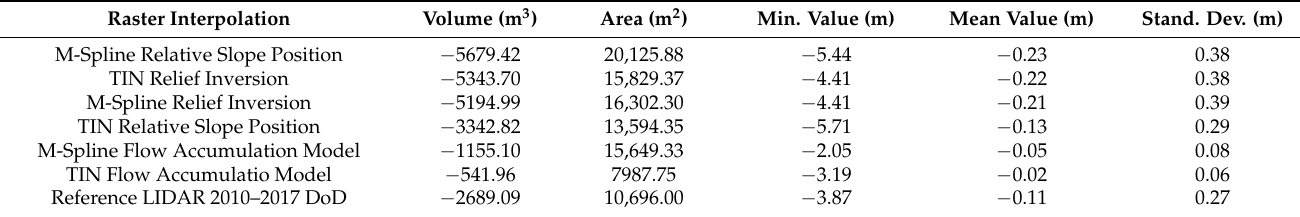
Table 1. Statistical data for the different gully detection methods used. The reference data for validation are the DEM of Differences (DoD) at 1.00 m spatial resolution obtained from airborne Lidar data sensed in 2010 and 2017 (local official mapping agency